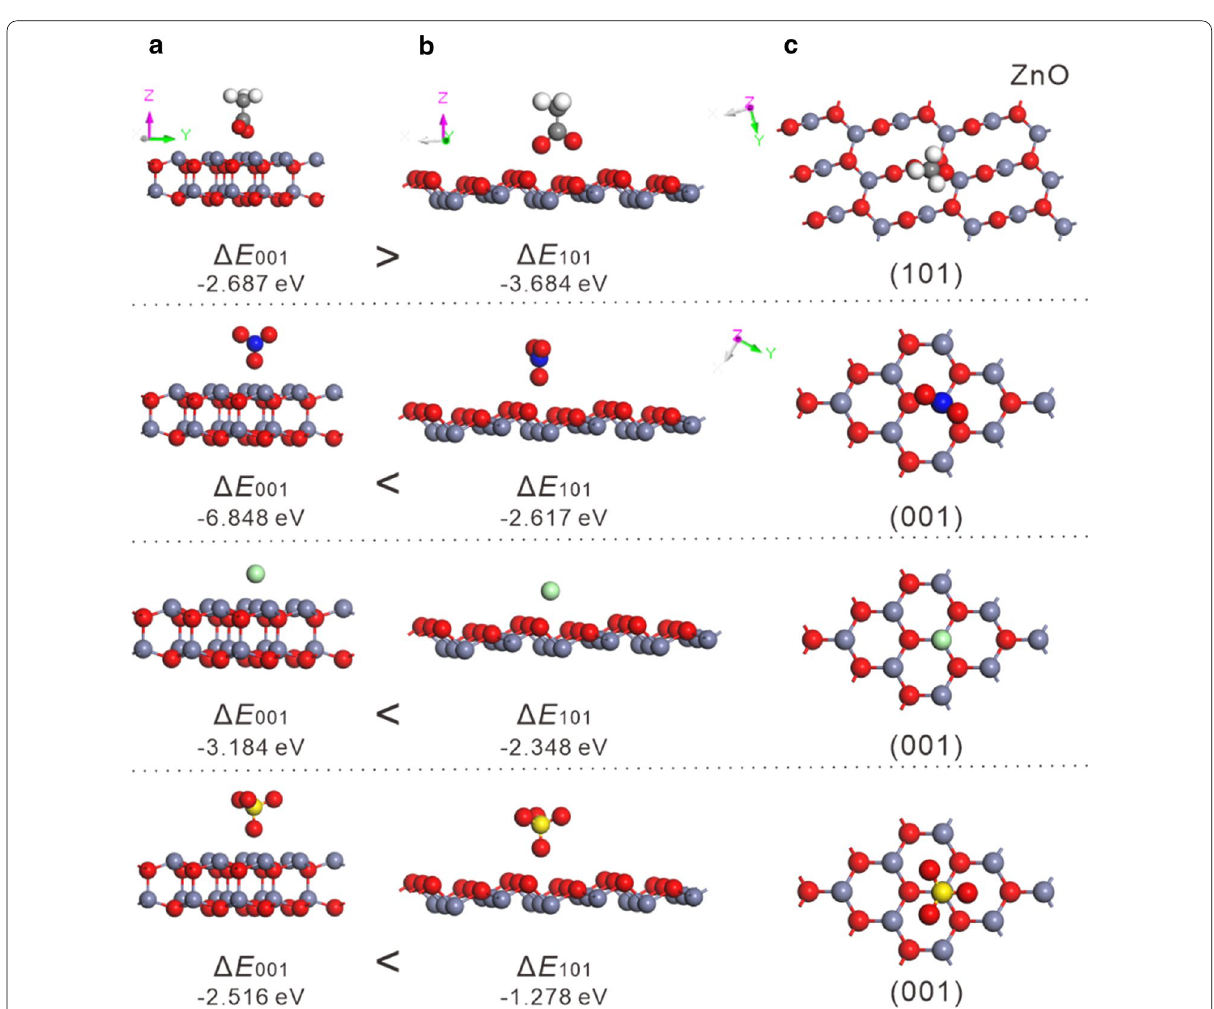
Fig. 4 Side view of the optimized structures of anions adsorbed on a (001) facet and b (101) facet. c Top view of the optimized structures of anions adsorbed on (001) facet and (101) facet. The diagram illustrates the calculated Δ E before and after anion binding. Anions from top to down: acetate